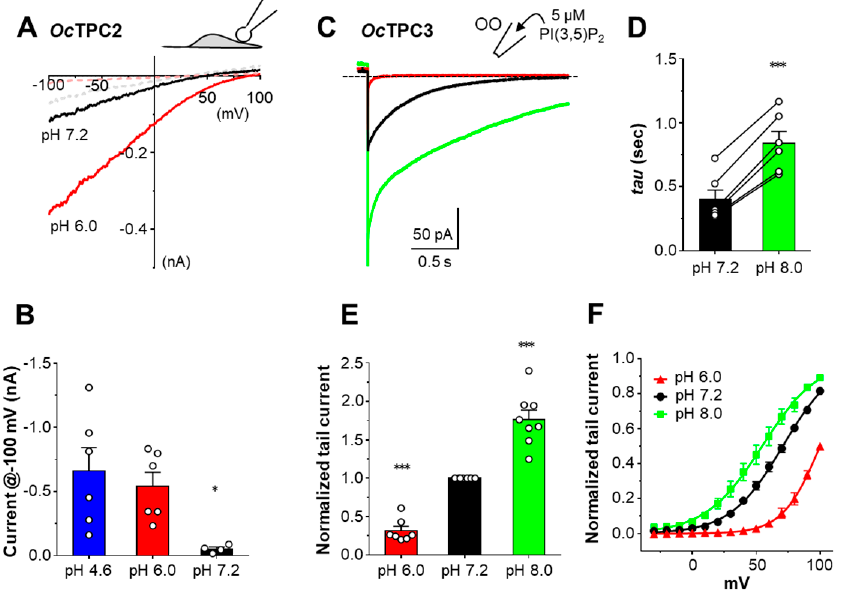
Figure 7. Oc TPC2 prefers acidic pH, while Oc TPC3 is more active at alkaline extracytosolic pH. HEK293 cells were transiently transfected with cDNA coding for Oc TPC2-EGFP or Oc TPC3-EGFP. ( A ) Representative I–V curves derived from voltage ramps for Oc TPC2 in whole-endolysosome (WL) patches with pipette solutions having pH 7.2 and pH 6.0. The patch was unstimulated ( dashed lines ) or exposed to 1 µ M PI(3,5)P 2 ( solid lines ). Traces from two different patches were overlaid for comparison between pH 6.0 and pH 7.2. See Figure 2B left for an example of pH 4.6. ( B ) Summary of current amplitude at − 100 mV recorded as in ( A ). Data are means ± SEM for n = 4–6 patches, with individual data points shown as while circles. * p < 0.05, different from pH 4.6 by one-way ANOVA with Tukey’s multiple comparisons test. ( C ) Representative current traces of Oc TPC3 detected in an outside-out (OO) patch with the pipette solution containing 5 µ M PI(3,5)P 2 and the patch sequentially exposed to pH 7.2 ( black ), pH 6.0 ( red ), and then pH 8.0 ( green ) bath solutions. The voltage was stepped from the holding potential at 0 mV to +100 mV for 4 s before returning to 0 mV. For clarity, only the last 0.14 s of the +100-mV step is shown together with the tail currents at 0 mV. Dashed line indicates zero current. ( D ) Summary of inactivation time constant ( tau ) for tail currents at pH 7.2 and pH 8.0 for Oc TPC3 recorded as in ( C ). Data are means ± SEM for n = 6 patches. *** p < 0.001 by paired t -test. ( E ) Summary of tail current normalized to that at pH 7.2 for Oc TPC3 recorded as in ( C ). Data are means ± SEM for n = 7–8 patches. *** p < 0.001, different from the theoretical mean of 1 by one-sample t -test. ( F ) G–V curves for patches recorded as in ( C ) but with tail currents obtained after step pulses to different potentials. Data are means ± SEM for n = 6 (pH 7.2, same data from Figure 5F), n = 4 (pH 8.0), and n = 3 (pH 6.0) patches fit by the Boltzmann